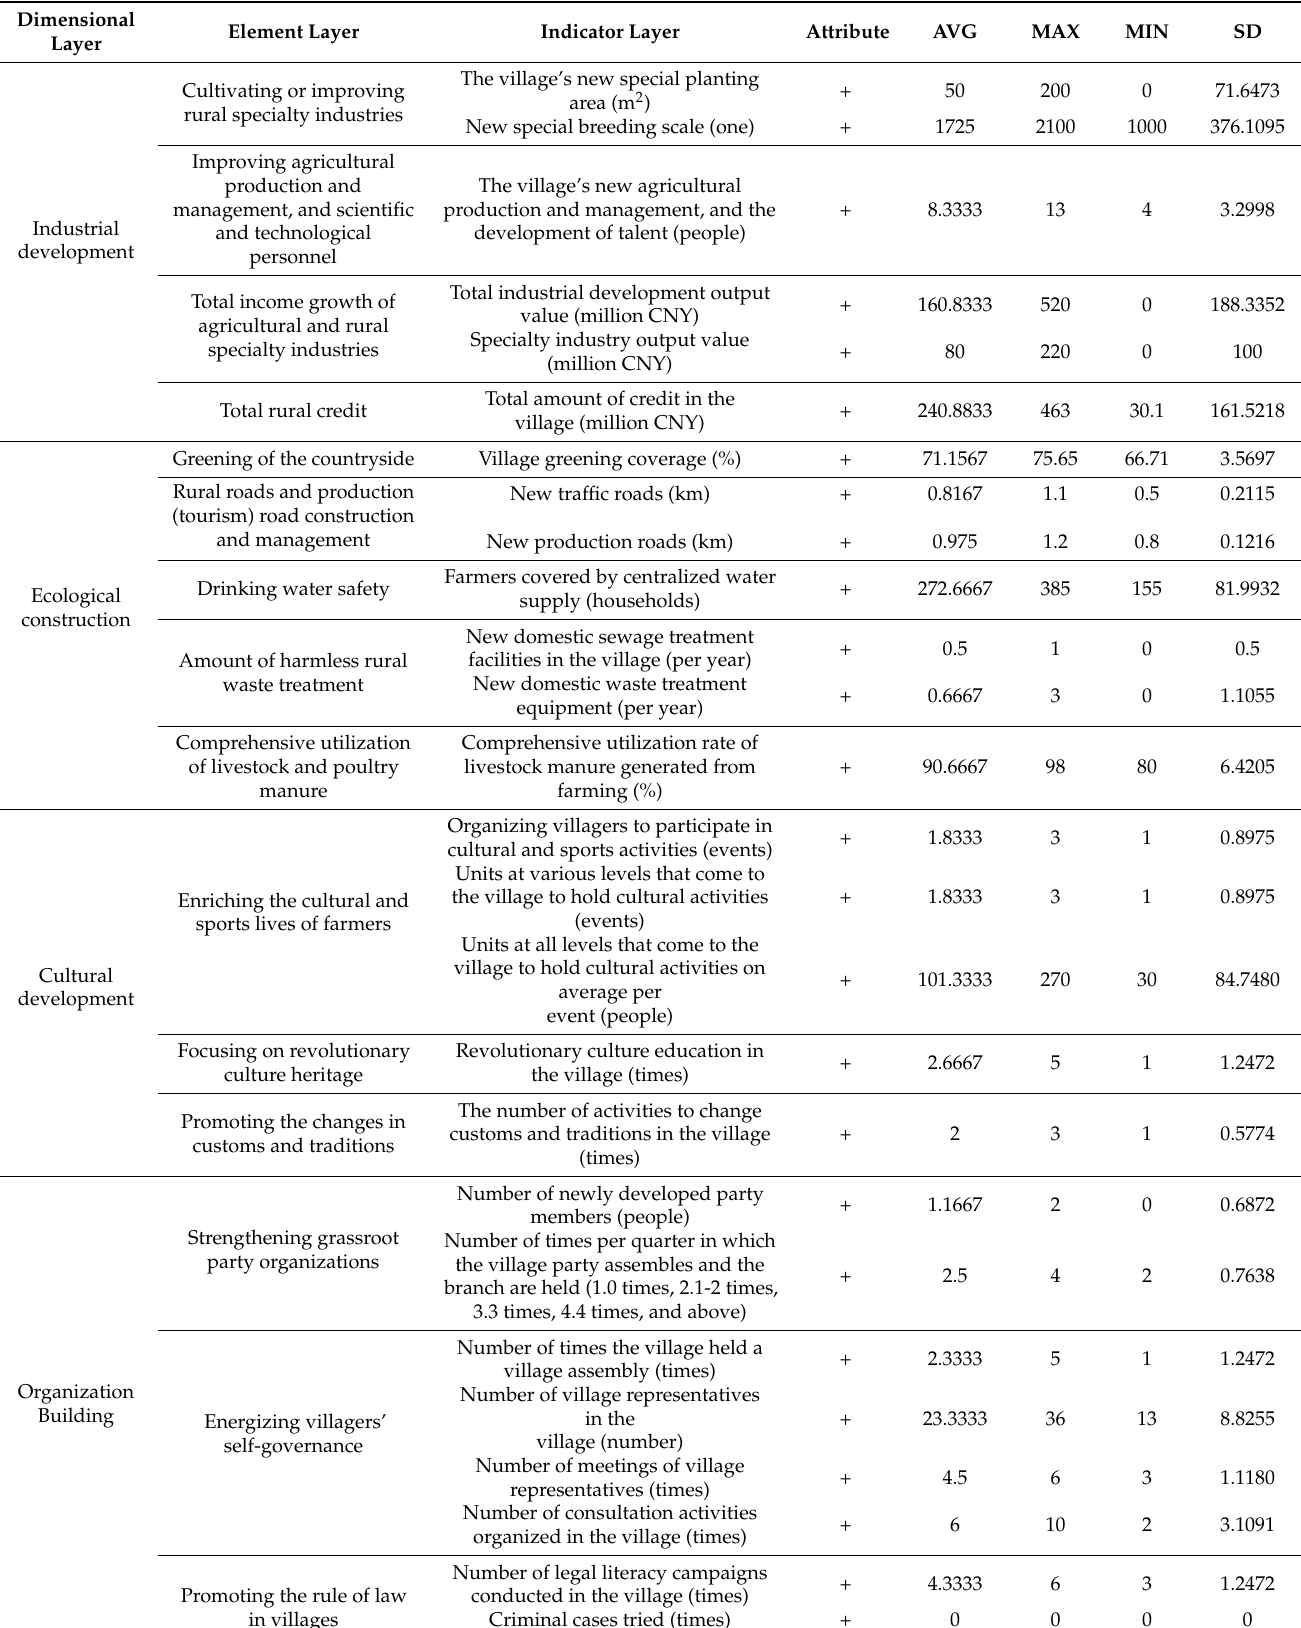
Table 1. Index system for evaluating the effectiveness of rural